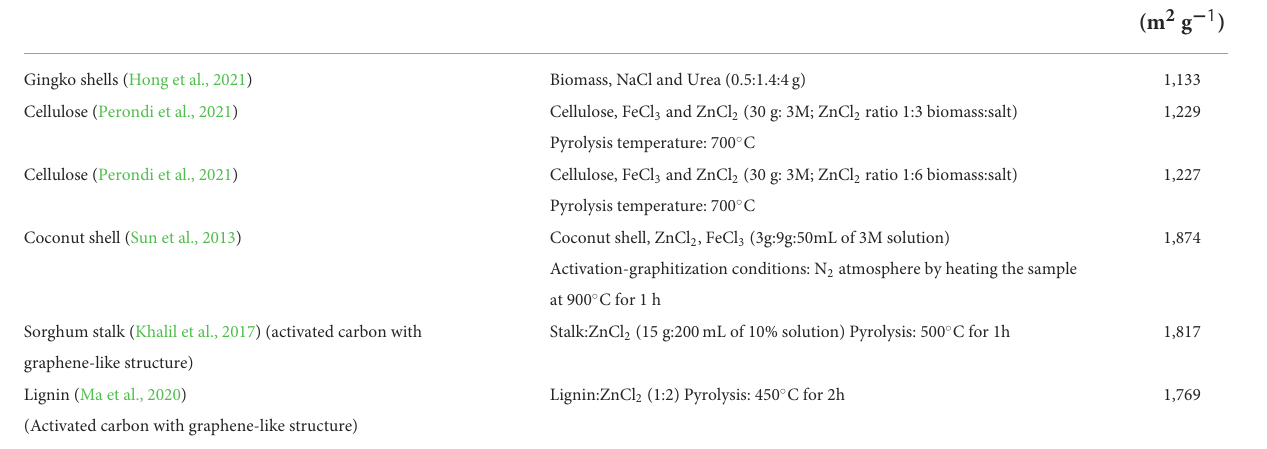
TABLE 1 Summary of conditions used to prepare G and GBM and their surface